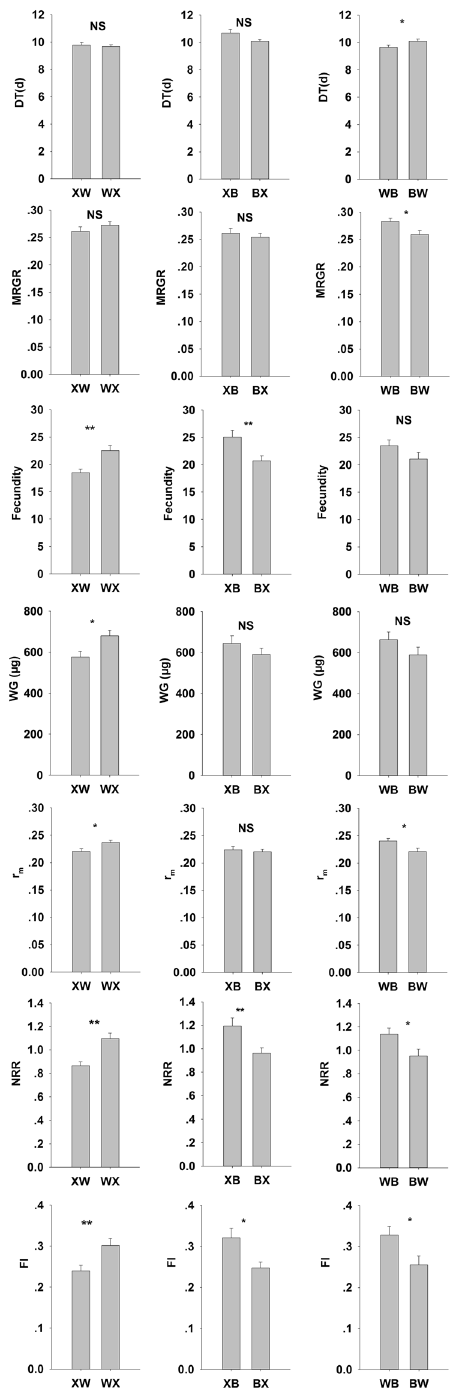
Figure 6. The life-history trait values of different populations offspring aphids reciprocally shifted